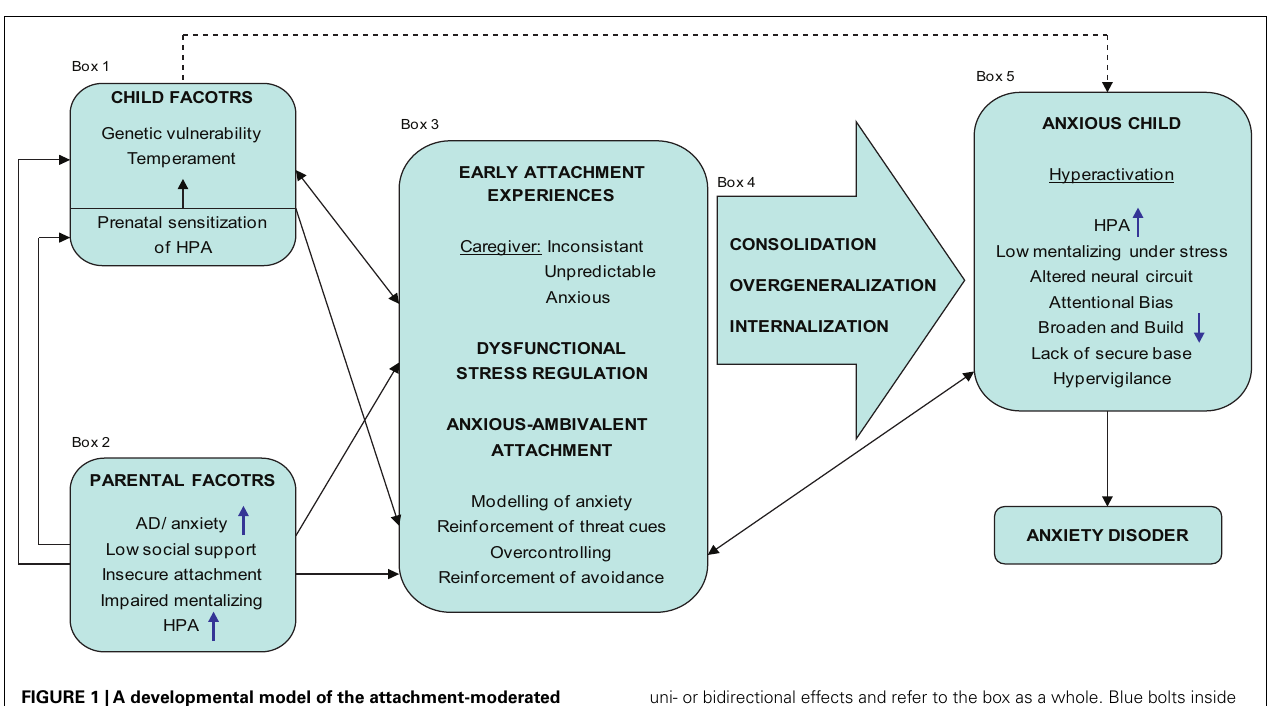
FIGURE 1 |A developmental model of the attachment-moderated interaction of risk factors in the development of anxiety disorders. Black bolts from one box to another indicate either